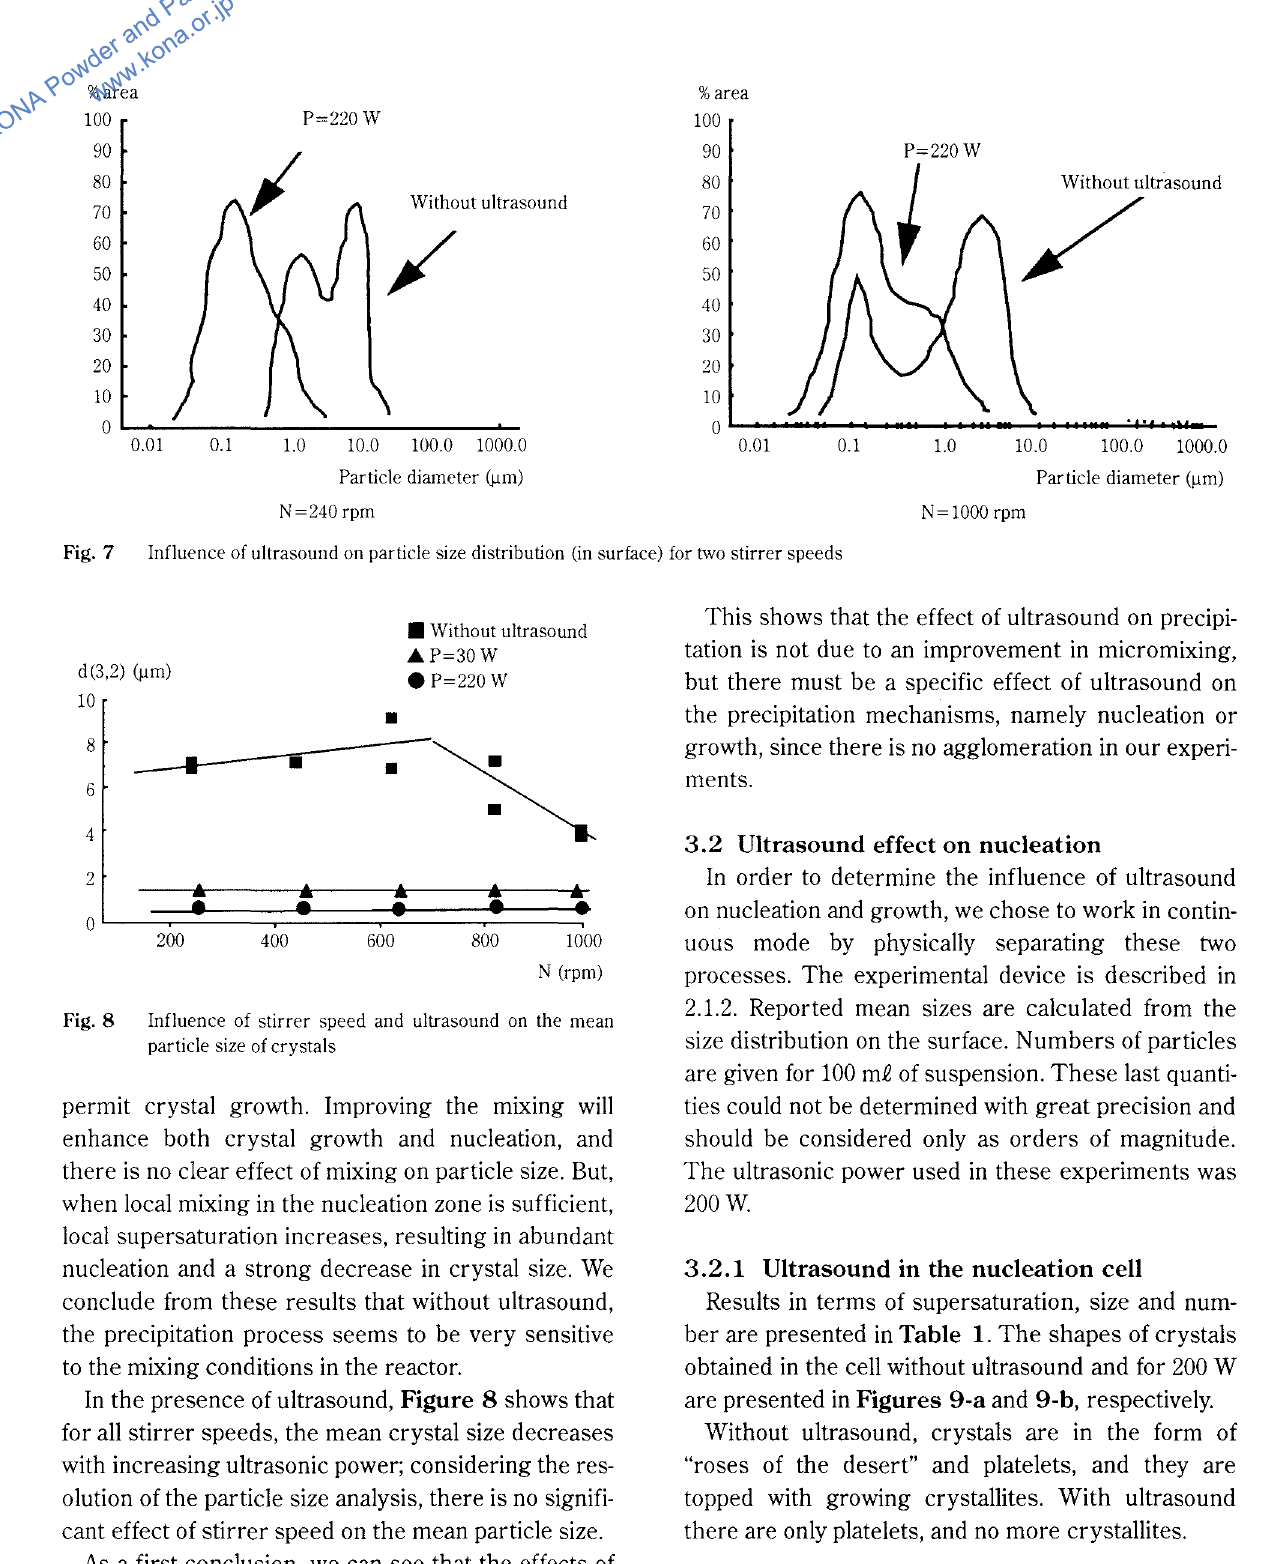
Table 1 Ultrasound effect in the nucleation